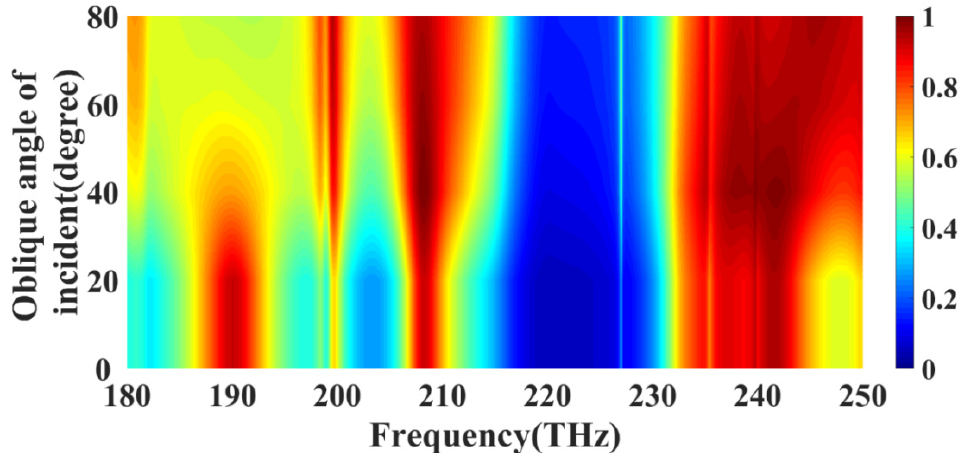
Figure 6. Variation in absorption peaks for the different values of the silica thickness.